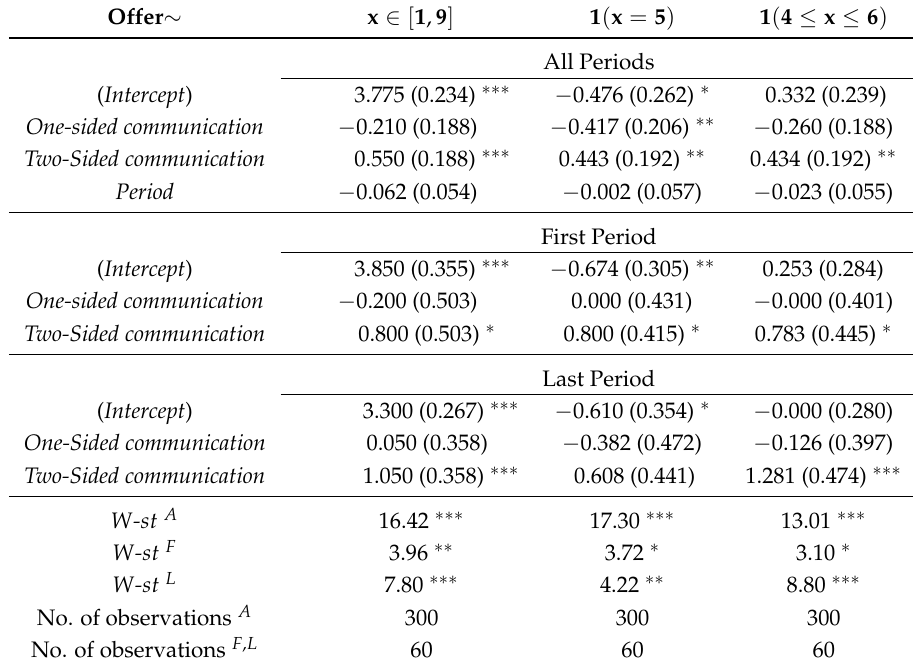
Table 3. Choices of X (Random Effects: linear and